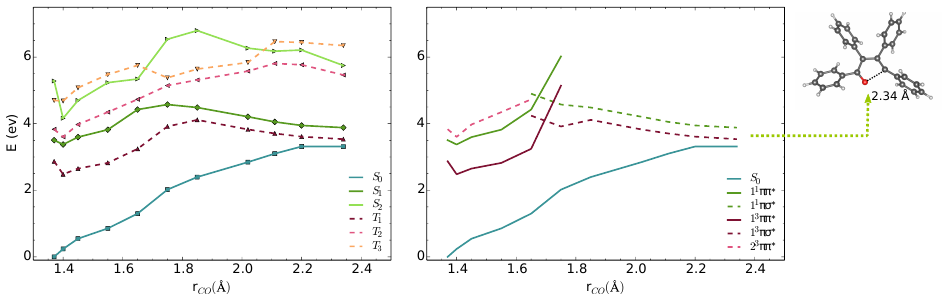
Figure 3. MS-3-CASPT2/CASSCF(10,10)/6-31G(d) energies of S 0 –S 2 and T 1 –T 3 states along interpo- lated pathway between FC point, S 1 minimum and S 1 –S 0 MECI geometry in vacuum. The states are shown in adiabatic ( left ) and diabatic representation ( right ). The diabatic representation was obtained by connecting the excited states corresponding to the same type of transitions along the